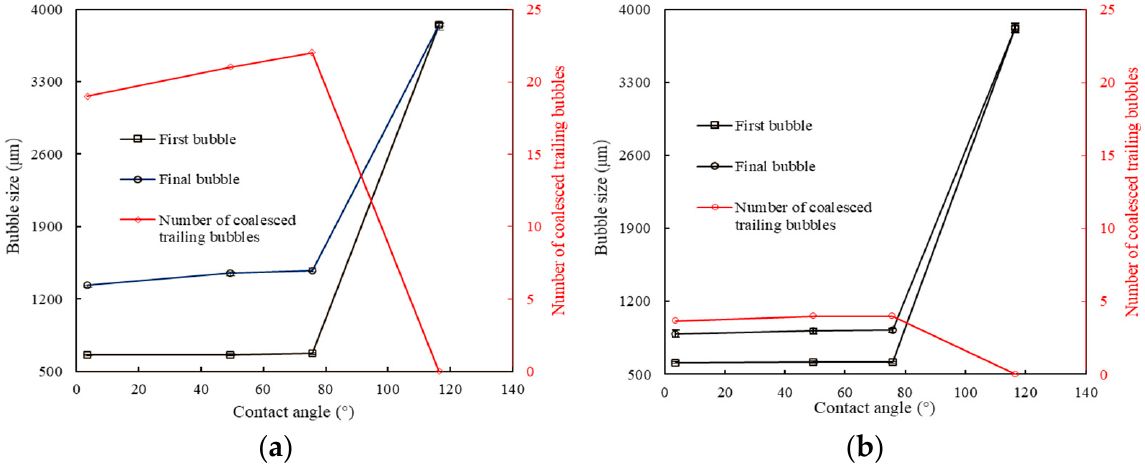
Figure 3. The bubble size and number of coalesced trailing bubbles under steady air pattern ( a ) and oscillatory air pattern ( b ).